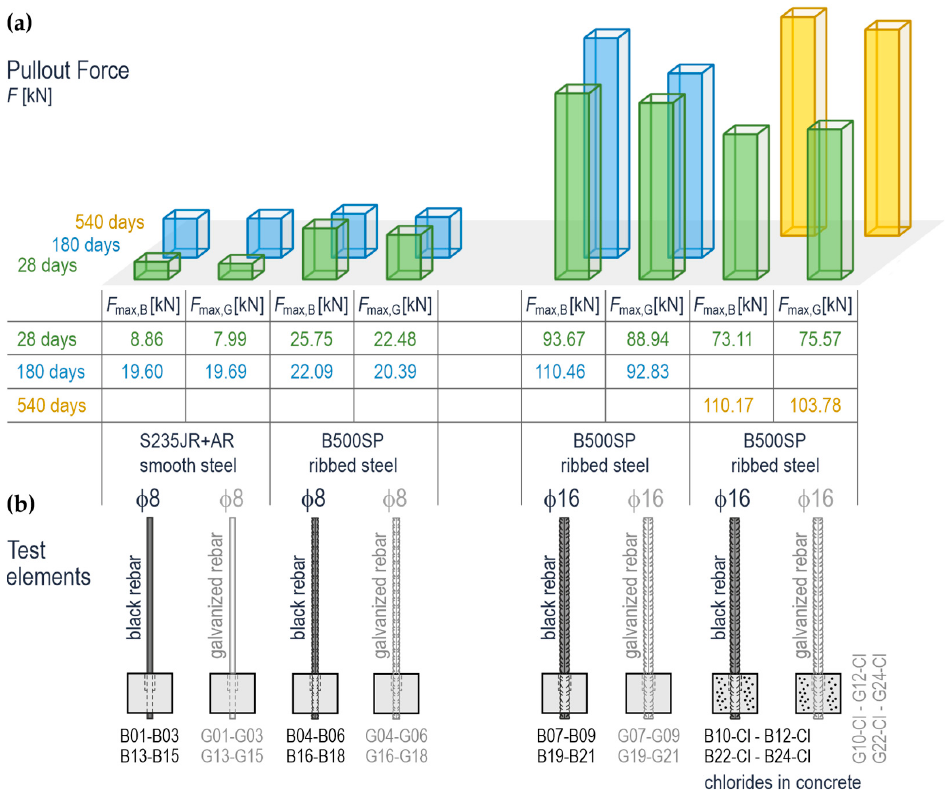
Figure 14. Mean values of the pull-out forces acting on galvanized and black steel (smooth φ 8 mm and ribbed φ 8 mm and φ 16 mm) in the concrete specimens with and without chlorides after 28, 180, and 540 days from their preparation: ( a ) bar chart and corresponding values from the table, ( b ) the test elements; F max,B —the pull-out force acting on black steel rebars averaged from three specimens, F max,G —the pull-out force acting on galvanized rebars averaged from three specimens.